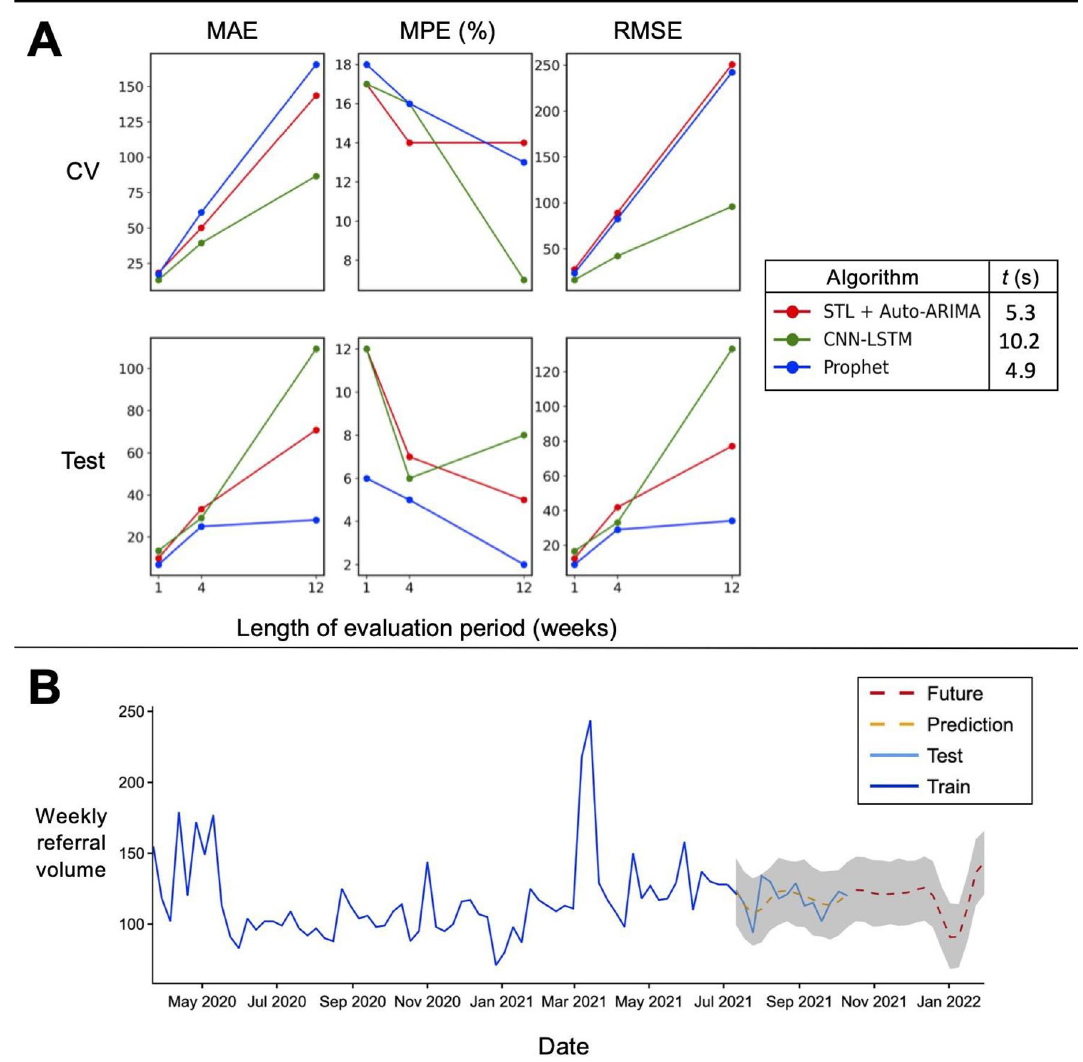
Figure 7. Time-series algorithm performance and prediction of future referral volume. ( A ) Evaluation of time-series forecasting algorithms using fivefold block cross-validation (CV) and train-test split (Test) using mean absolute error (MAE), mean absolute predictive error (MPE) and root mean squared error (RMSE) with 1, 4 and 12 week forecasting periods. Algorithm legend: computational time ( t ) taken to run onefold of each algorithm ( STL seasonal and trend decomposition using Loess, CNN-LSTM convolutional neural network— long short-term memory, ARIMA automated regression integrated moving average). ( B ) Timeline of weekly referral volumes plotted since the start of the Covid-19 pandemic with in-sample forecasting (prediction: yellow dashed line) and 12-week out-of-sample forecasting (future: red dashed line) determined by Prophet with 95% confidence intervals shown in gray.